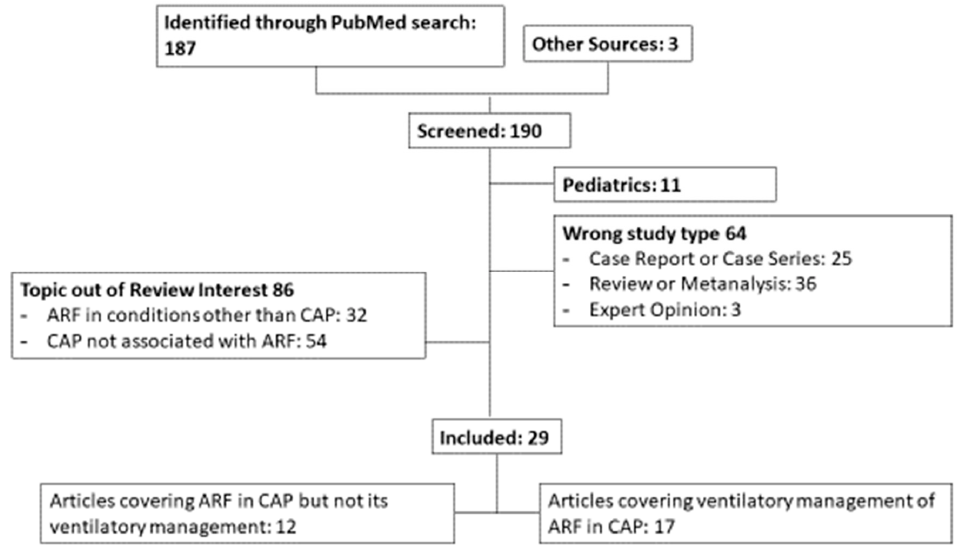
Figure 1. Diagrammatic overview of the review process. CAP: community-acquired pneumonia; ARF: acute respiratory failure.